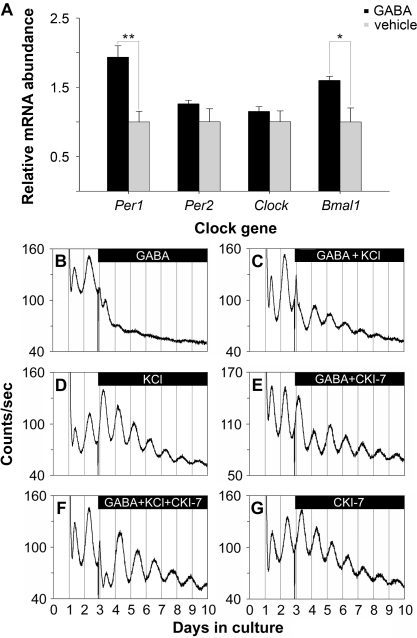
GABA Acts Posttranscriptionally through Membrane Polarization and Casein Kinase(A) Shown are relative mRNA abundance of Per1, Per2, Clock, and Bmal1 in retinal explants 8 h after treatment with 3 mM GABA (black) or vehicle (grey) started at the beginning of the third circadian cycle. Clock gene mRNA levels were normalized to the mRNA levels of GAPDH. The average mRNA levels of vehicle-treated samples were set to 1.0. Data are presented as means ± SEM (n = 4). GABA did not significantly change the transcript levels of Per2 and Clock, while significantly increased the transcript levels of Per1 and Bmal1. A single asterisk (*)indicates p < 0.05; double asterisks (**) indicate p < 0.01; Student's t-test.(B) GABA (1 mM) greatly suppressed retinal PER2::LUC rhythms.(C) Depolarization with elevated K+ (4 mM) partially blocked the inhibitory effect of GABA (1 mM) on retinal PER2::LUC rhythms.(D) Prolonged application of KCl (4 mM) modestly increased rhythmic PER2::LUC amplitudes.(E) Inhibition of casein kinase activity with CKI-7 (50 μM) partially rescued the inhibitory action of 1 mM GABA on retinal PER2::LUC rhythms.(F) KCl (4 mM) and CKI-7 (50 μM) greatly rescued the inhibitory action of GABA (1 mM) on retinal PER2::LUC rhythms when they were co-applied with GABA.(G) When CKI-7 (50 μM) was applied alone, it lengthened the period of retinal PER2::LUC rhythms.Bars in (B–G) indicate the duration of treatment.